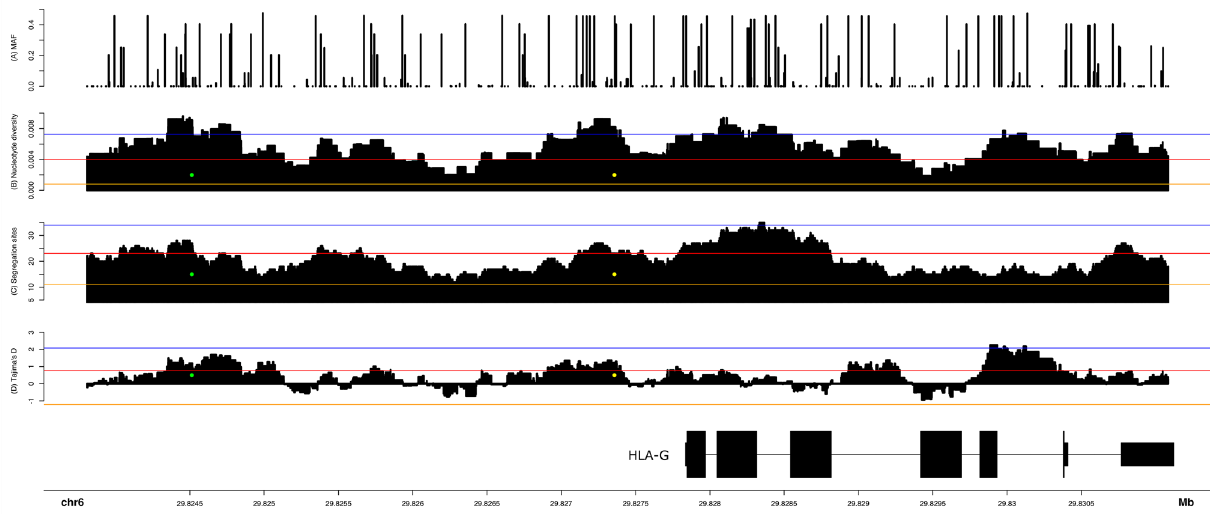
Figure 2. Frequency of each variant (panel A), nucleotide diversity (panel B), number of segregation sites (panel C), and Tajima’s D (panel D) across HLA-G, considering all samples from the 1000Genomes project pooled together, starting from approximately 4 kb upstream the gene (the promoter region) to 100 nucleotides downstream HLA-G. Panels B, C, and D were computed in sliding windows of 500 nucleotides and a step size of 1. The HLA-G exon/intron structure is indicated in the bottom panel, with fine lines indicating introns and thick lines indicating exons. To evaluate the significance of the parameters estimated from HLA-G , we